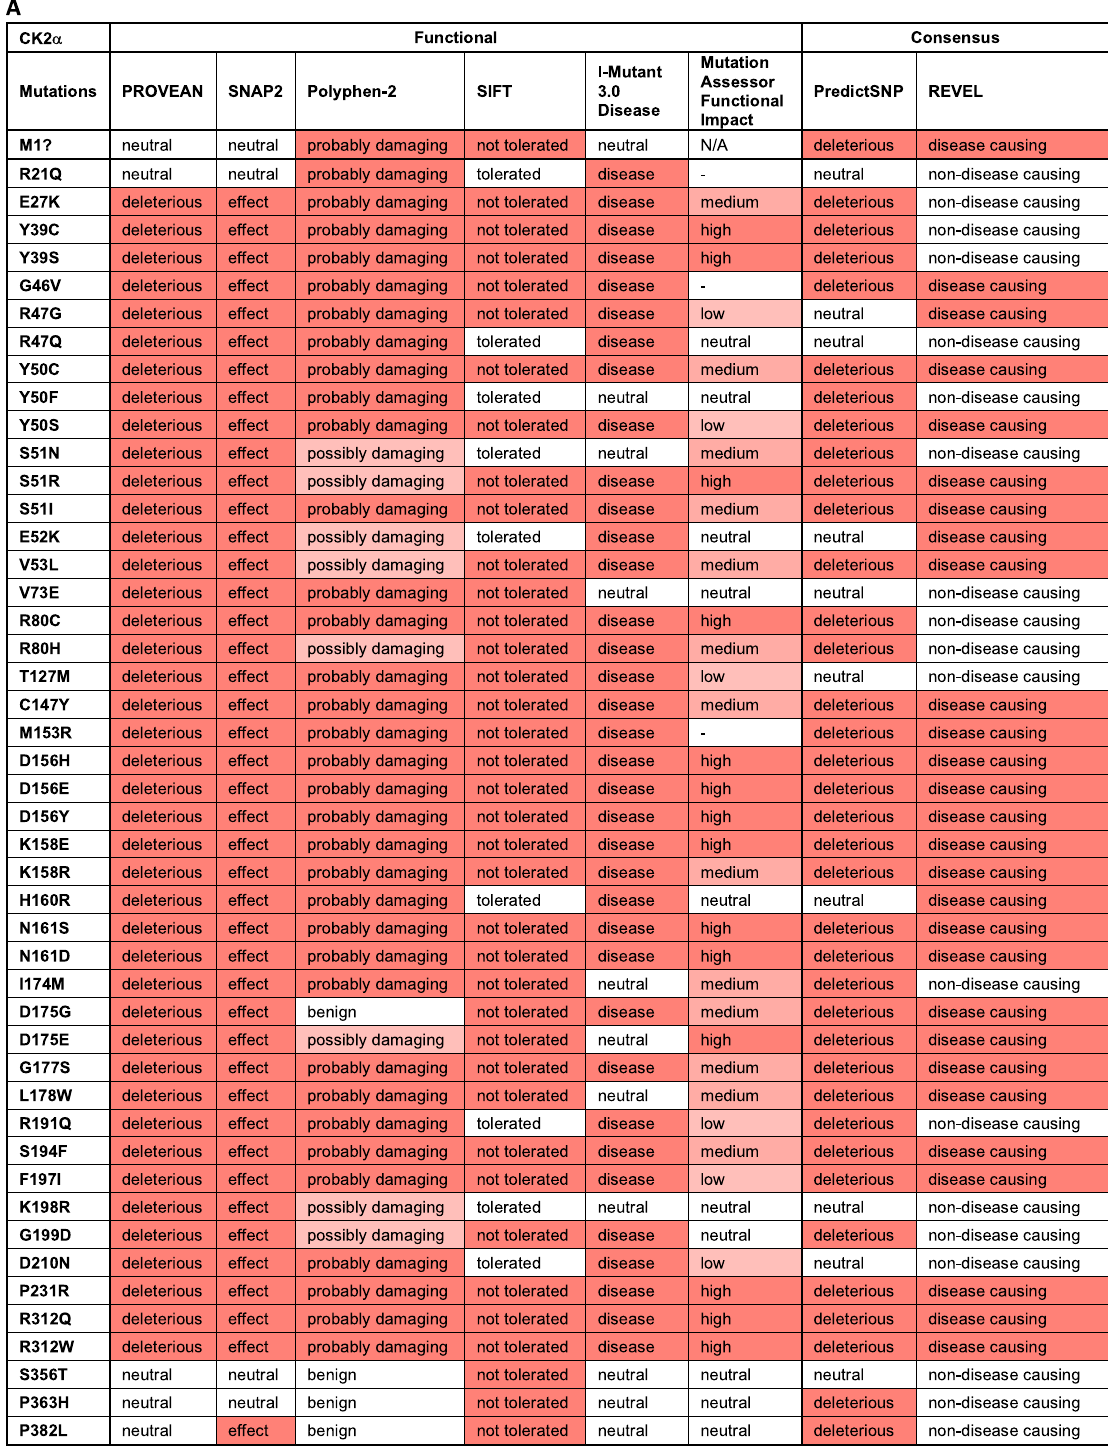
TABLE5Analysis ofCK2 α andCK2 β proteinmutationsusing functionalpredictionprograms. Predictionsfor CK2 α (A)and(B)CK2 β .Colorsinthecells re fl ect the effect from neutral (white) to high effect (red). The numbers obtained in the analysis can be found in Supplementary Table S4. (C, D) Comparison between CK2 α predictions and experimental data on CK2 α from Dominguez et al., 2021. (C) kinase activity of the recombinant CK2 α protein mutants puri fi ed from bacteria; from 0%to 25% (top rows) to 25% – 50% (bottom rows) compared to wild-type puri fi ed protein. (D)Degreeof similarity between nuclear/cytoplasmic localization CK2 α protein mutants to wild-type proteins expressed in cell lines; from low to high. N/A (= not applicable) indicates residues that could not generate a prediction. [Note: MutationAssessor has been down precluding us from analyzing 7 mutants, indicated with ( —